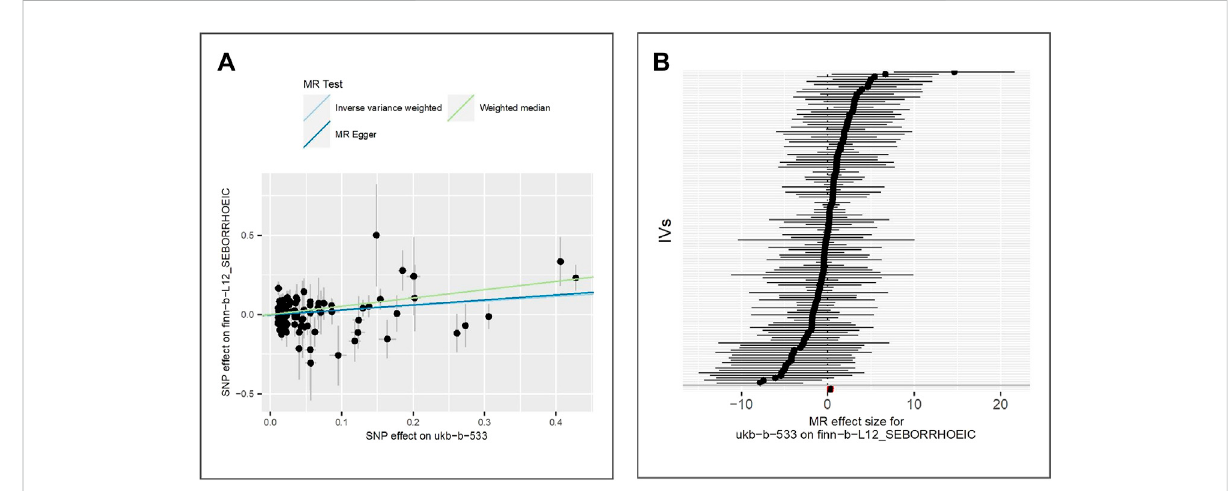
FIGURE 5 Comparison of MR methods and results associated with seborrhoeic dermatitis: (A) scatter plot re fl ects SNP effects on seborrhoeic dermatitis against SNP effects on the exposure; (B) forest plot represents the causal effect of exposure on the outcome using each SNP singly.